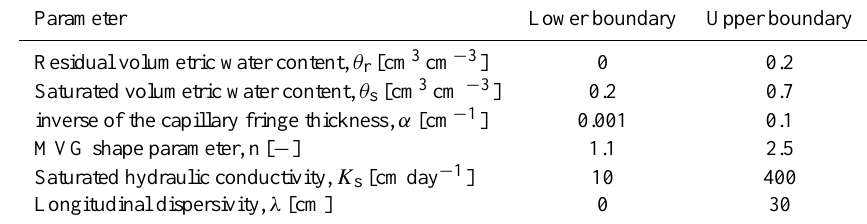
Table 2. Boundaries of the parameter space for the unconstrained inverse model approaches (uIPA, MOA, 2SA).